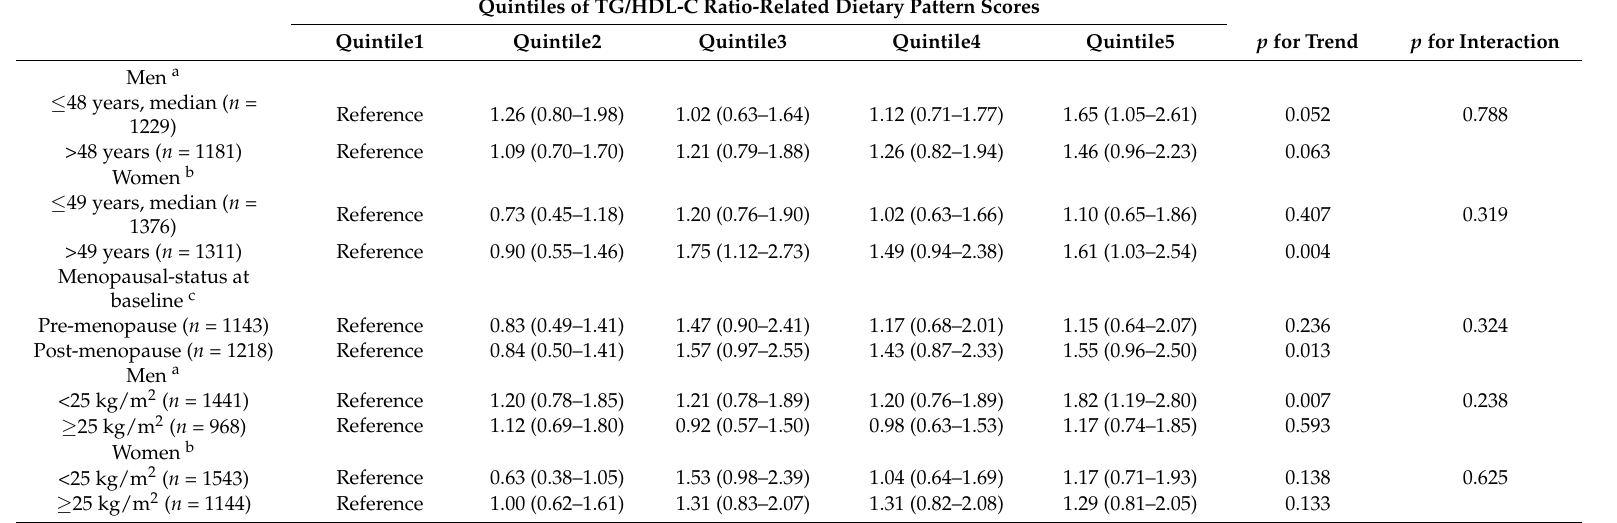
Table 4. Odds ratios (ORs) and 95% confidence intervals (CIs) of incident type 2 diabetes according to the quintiles of dietary pattern scores by age, menopausal status, and BMI at